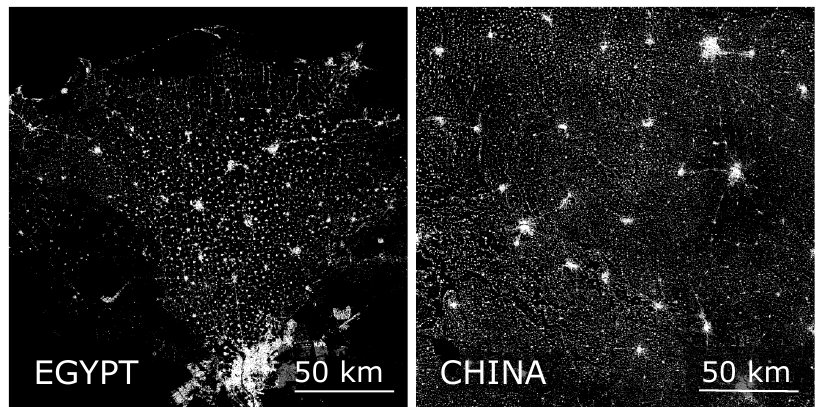
Figure 4. Parts of the Global Urban Footprint (GUF). The data set Egypt includes the Nile Delta ( left ), the investigated region in China is located in den province Henan and Anhui ( right